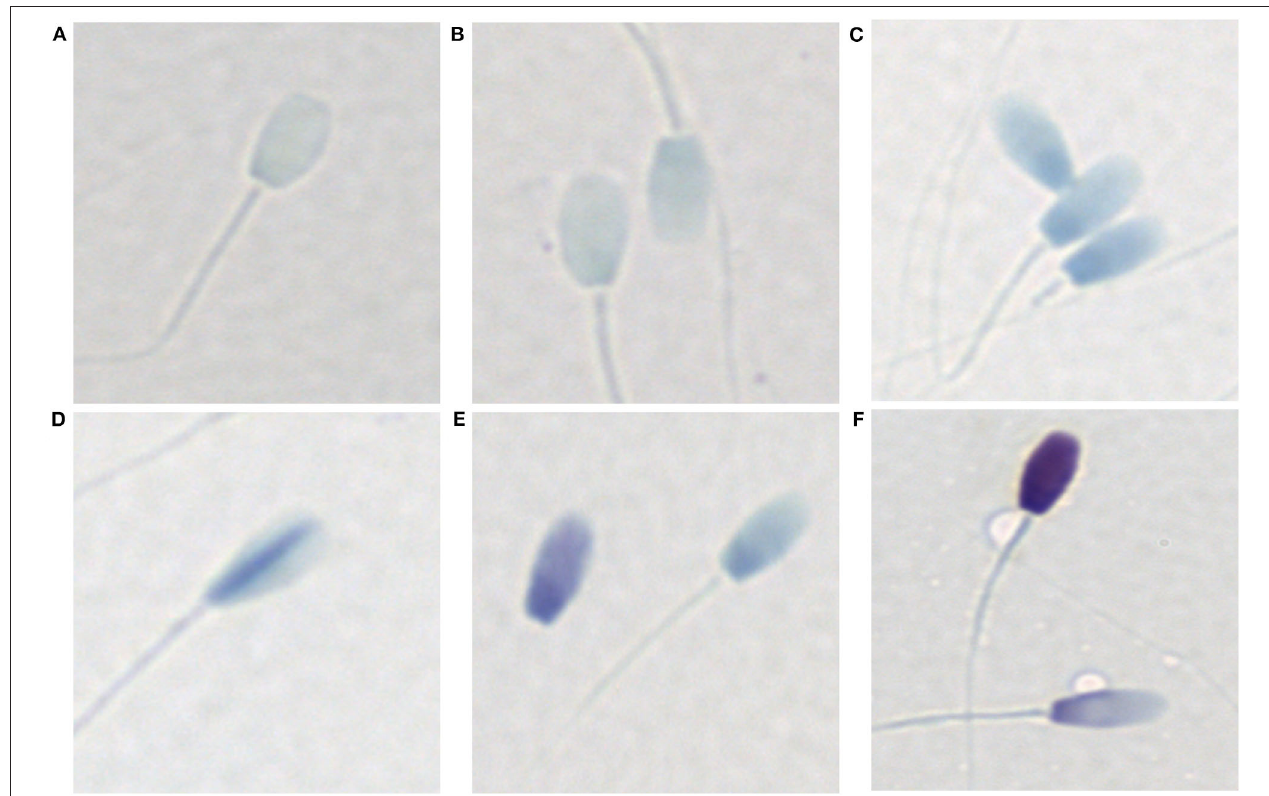
FIGURE 2 | Toluidine blue staining patterns associated with varying levels of chromatin condensation in the West Indian manatee. (A) no stain uptake, (B) very light pale blue (very slight stain uptake with bipolar orthochromatic staining), (C) light pale blue (slightly darker stain uptake with more defined bipolar orthochromatic staining), (D) dispersive dark blue (mostly light blue with dark blue dispersed, generally creating a line up the middle of the sperm head), (E) intermediate blue/violet (either darker blue or a light violet/purple color with or without bipolar staining), (F) dark blue/violet (intense blue/violet metachromatic staining). (A-C) are considered normal with normal chromatin condensation, (D–F) represent abnormal chromatin condensation with varying levels of chromatin decondensation.